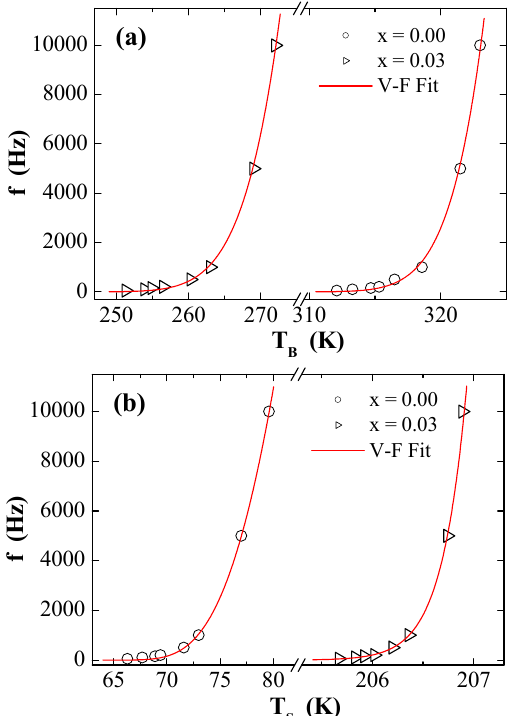
Figure 9. Plots of ( a ) f versus T B and ( b ) f versus T s for NiFe 2 − x Dy x O 4 ( x = 0.00 and 0.03) NPs (solid lines present the Vogel–Fulcher (V–F) fit).